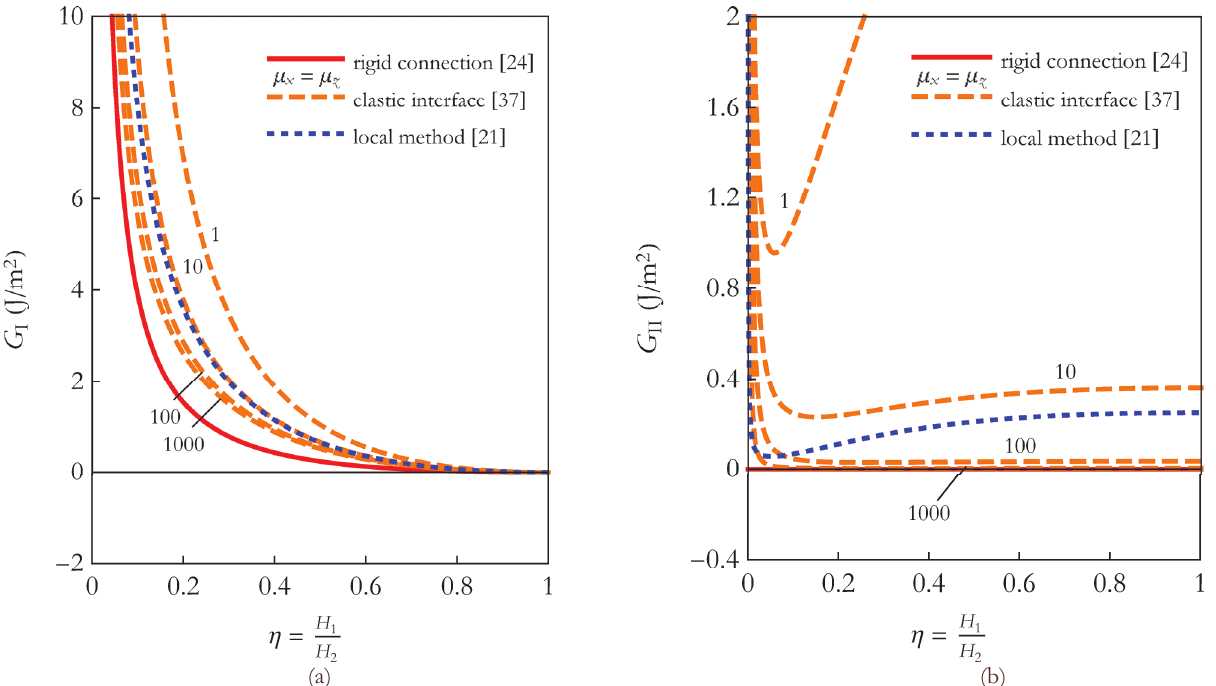
Figure 10: (a) Mode I and (b) mode II contributions to the energy release rate due to antisymmetric shear forces.